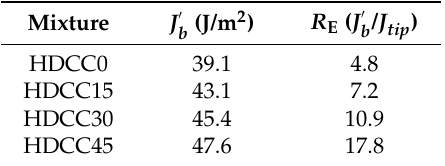
Table 6. Complementary energy of HDCCs.